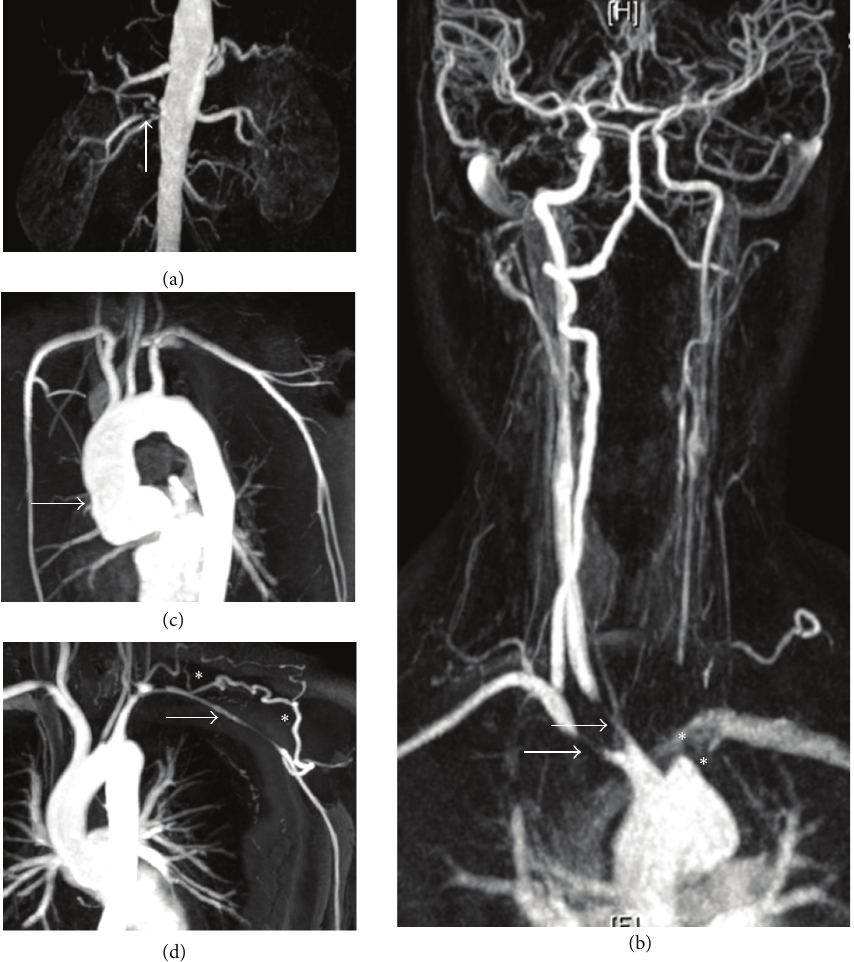
Figure 3: Indications for surgical intervention in Takayasu arteritis. Surgery should not be undertaken lightly in patients with TA. However, the outcome of intervention in those with serious complications is good and improved if disease activity can be controlled prior to surgery. The figure shows MRA studies. (a) A right renal artery stenosis subsequently successfully treated by percutaneous angioplasty with resolution of hypertension. (b) Severe disease of the great vessels including stenoses of the right subclavian and common carotid arteries (arrows) and occlusion of the left subclavian and left common carotid arteries (stars). The patient suffered severe cerebrovascular symptoms and underwent successful bypass surgery. (c) A dilated ascending aorta with associated severe aortic regurgitation in a young female patient who required aortic valve replacement. (d) Although patients commonly suffer claudication symptoms as a consequence of subclavian artery stenosis (arrow), these often improve following the development of collaterals (stars) as shown here, precluding the need for intervention.